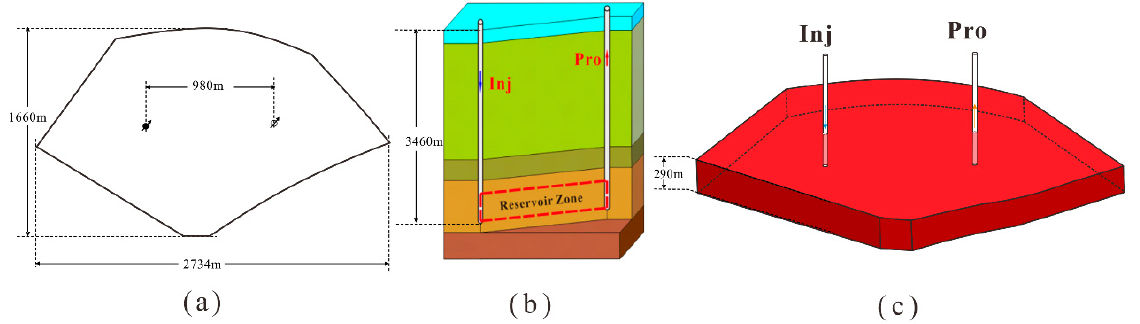
Figure 2. Schematic of the geothermal reservoir, ( a ) wells location and model scale, ( b ) depth, ( c ) thickness.